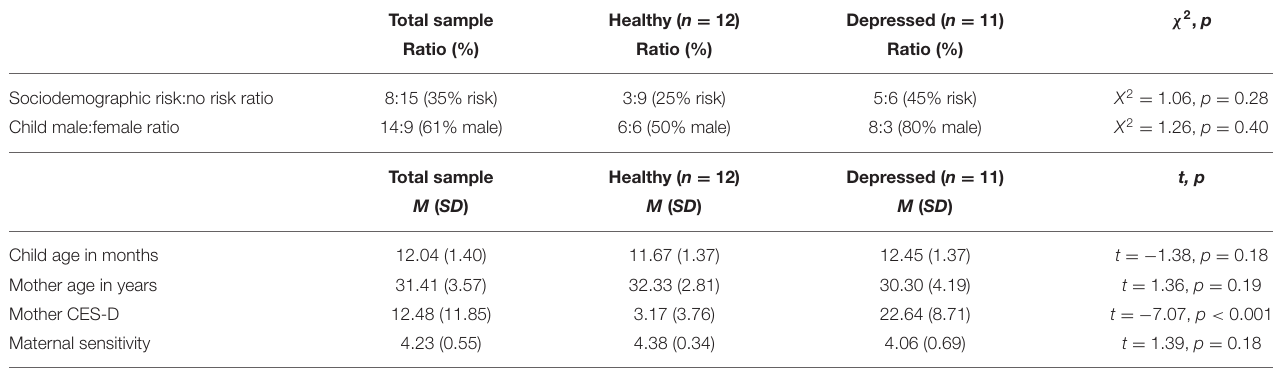
TABLE 1 | Descriptive statistics.